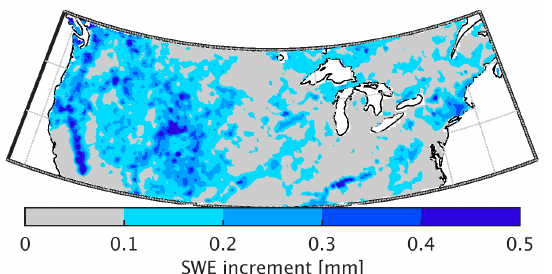
Figure 9. Time-average of the absolute value of SWE increments (i.e., the difference in DA − OL) across the eight-year study period.